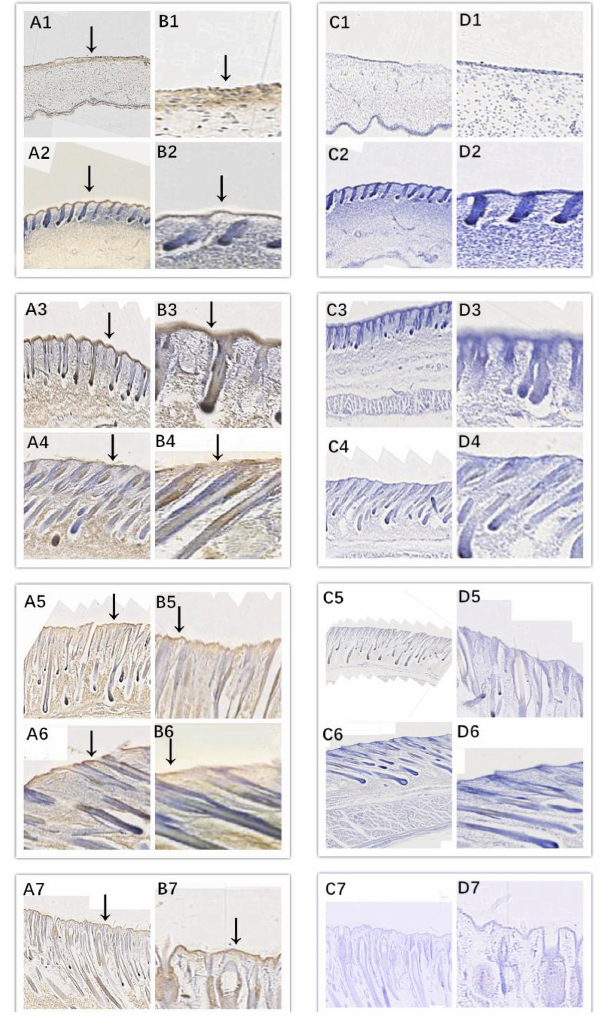
Figure 3. Location of EDA expression. Note: A1–A7, B1–B7, C1– C7, and D1–D7 are longitudinal section views of the skin tissue of Inner Mongolian cashmere goats at 45, 55, 65, 75, 95, 115, and 135d, respectively. The magnification of the results in the first and third columns was × 100, that of the second and fourth columns was × 400, and the third and fourth columns were negative con- trols. A1–A7, B1–B7, C1–C7, and D1–D7 show the follicle slitting